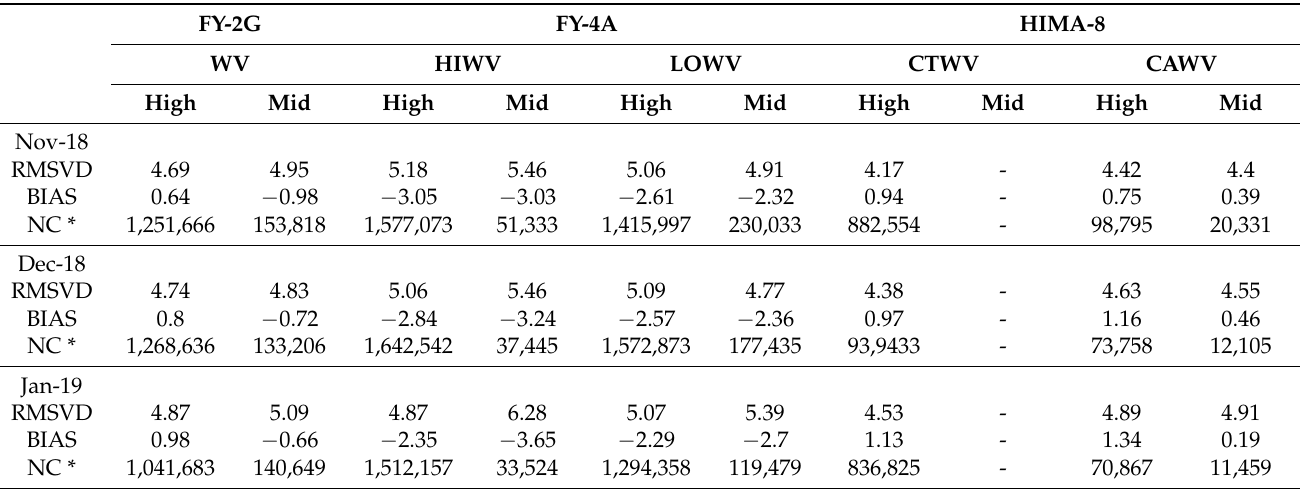
Table 3. Monthly comparison of homogeneous samples of FY-2G, FY-4A, and HIMA-8 water vapour AMVs with respect to NCEP FNL wind analysis for different atmospheric levels over the retrieval domain at QI 85% for the three months starting from 1 November 2018 to 31 January